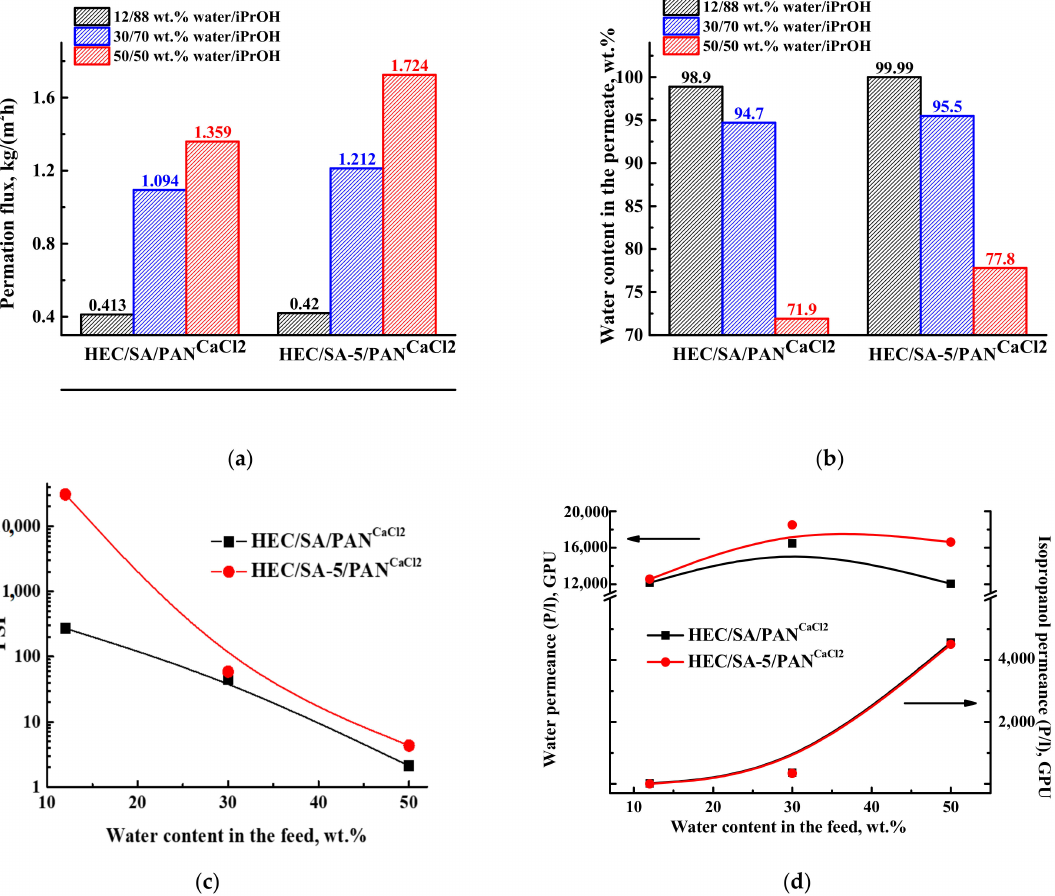
Figure 12. The dependence of ( a ) permeation flux, ( b ) water content in the permeate, ( c ) pervaporation separation index (PSI), and ( d ) component permeances on the water content in the feed for the supported cross-linked HEC/SA/PAN CaCl2 and HEC/SA-5/PAN CaCl2 membranes in pervaporation dehydration of isopropanol (12–50 wt.% water) at 22 ◦